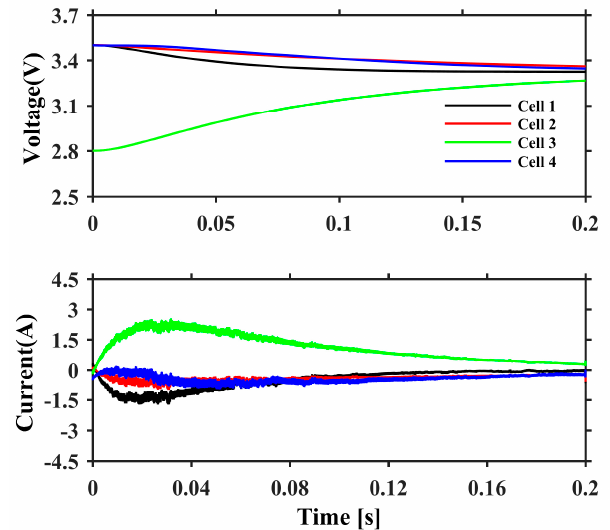
Figure 4. Simulation results for MSIBC with constant equal mode duration.